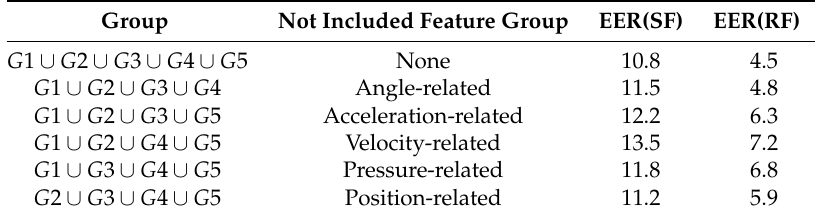
Figure 6. Results of function features-based verification method (FF). ( a ) ROC curves under common threshold. ( b ) EER of each user under user threshold. Table 4. Comparisons between different group of function features.